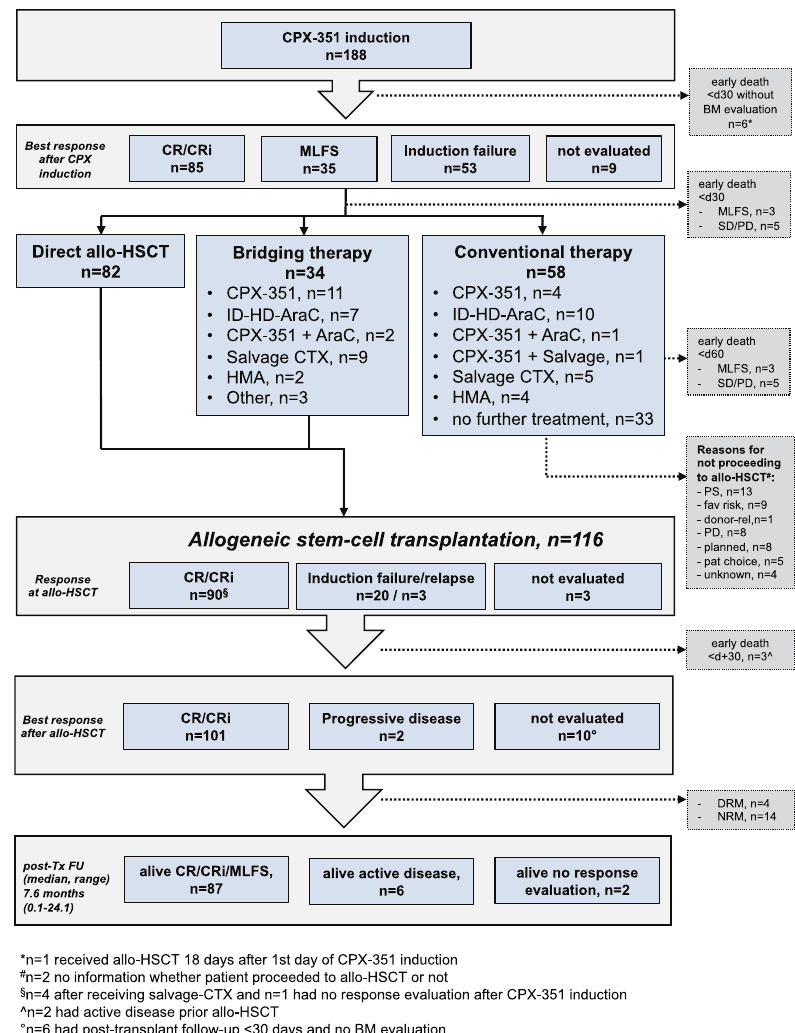
Fig. 1 Flow chart depicting treatment, response, and outcome of the study population. Allo-HSCT allogeneic hematopoietic stem cell transplantation, BM bone marrow, CR complete remission, CRi complete remission with incomplete hematologic recovery, CTX chemotherapy, DRM disease-related mortality, d day, fav favorable, FU follow-up, HD-AraC high-dose cytarabine, ID-AraC intermediate dose cytarabin, MLFS morphologic leukemia-free state, NRM non-relapse mortality, pat patient, PD progressive disease, PS performance status, rel related, SD stable disease, Tx